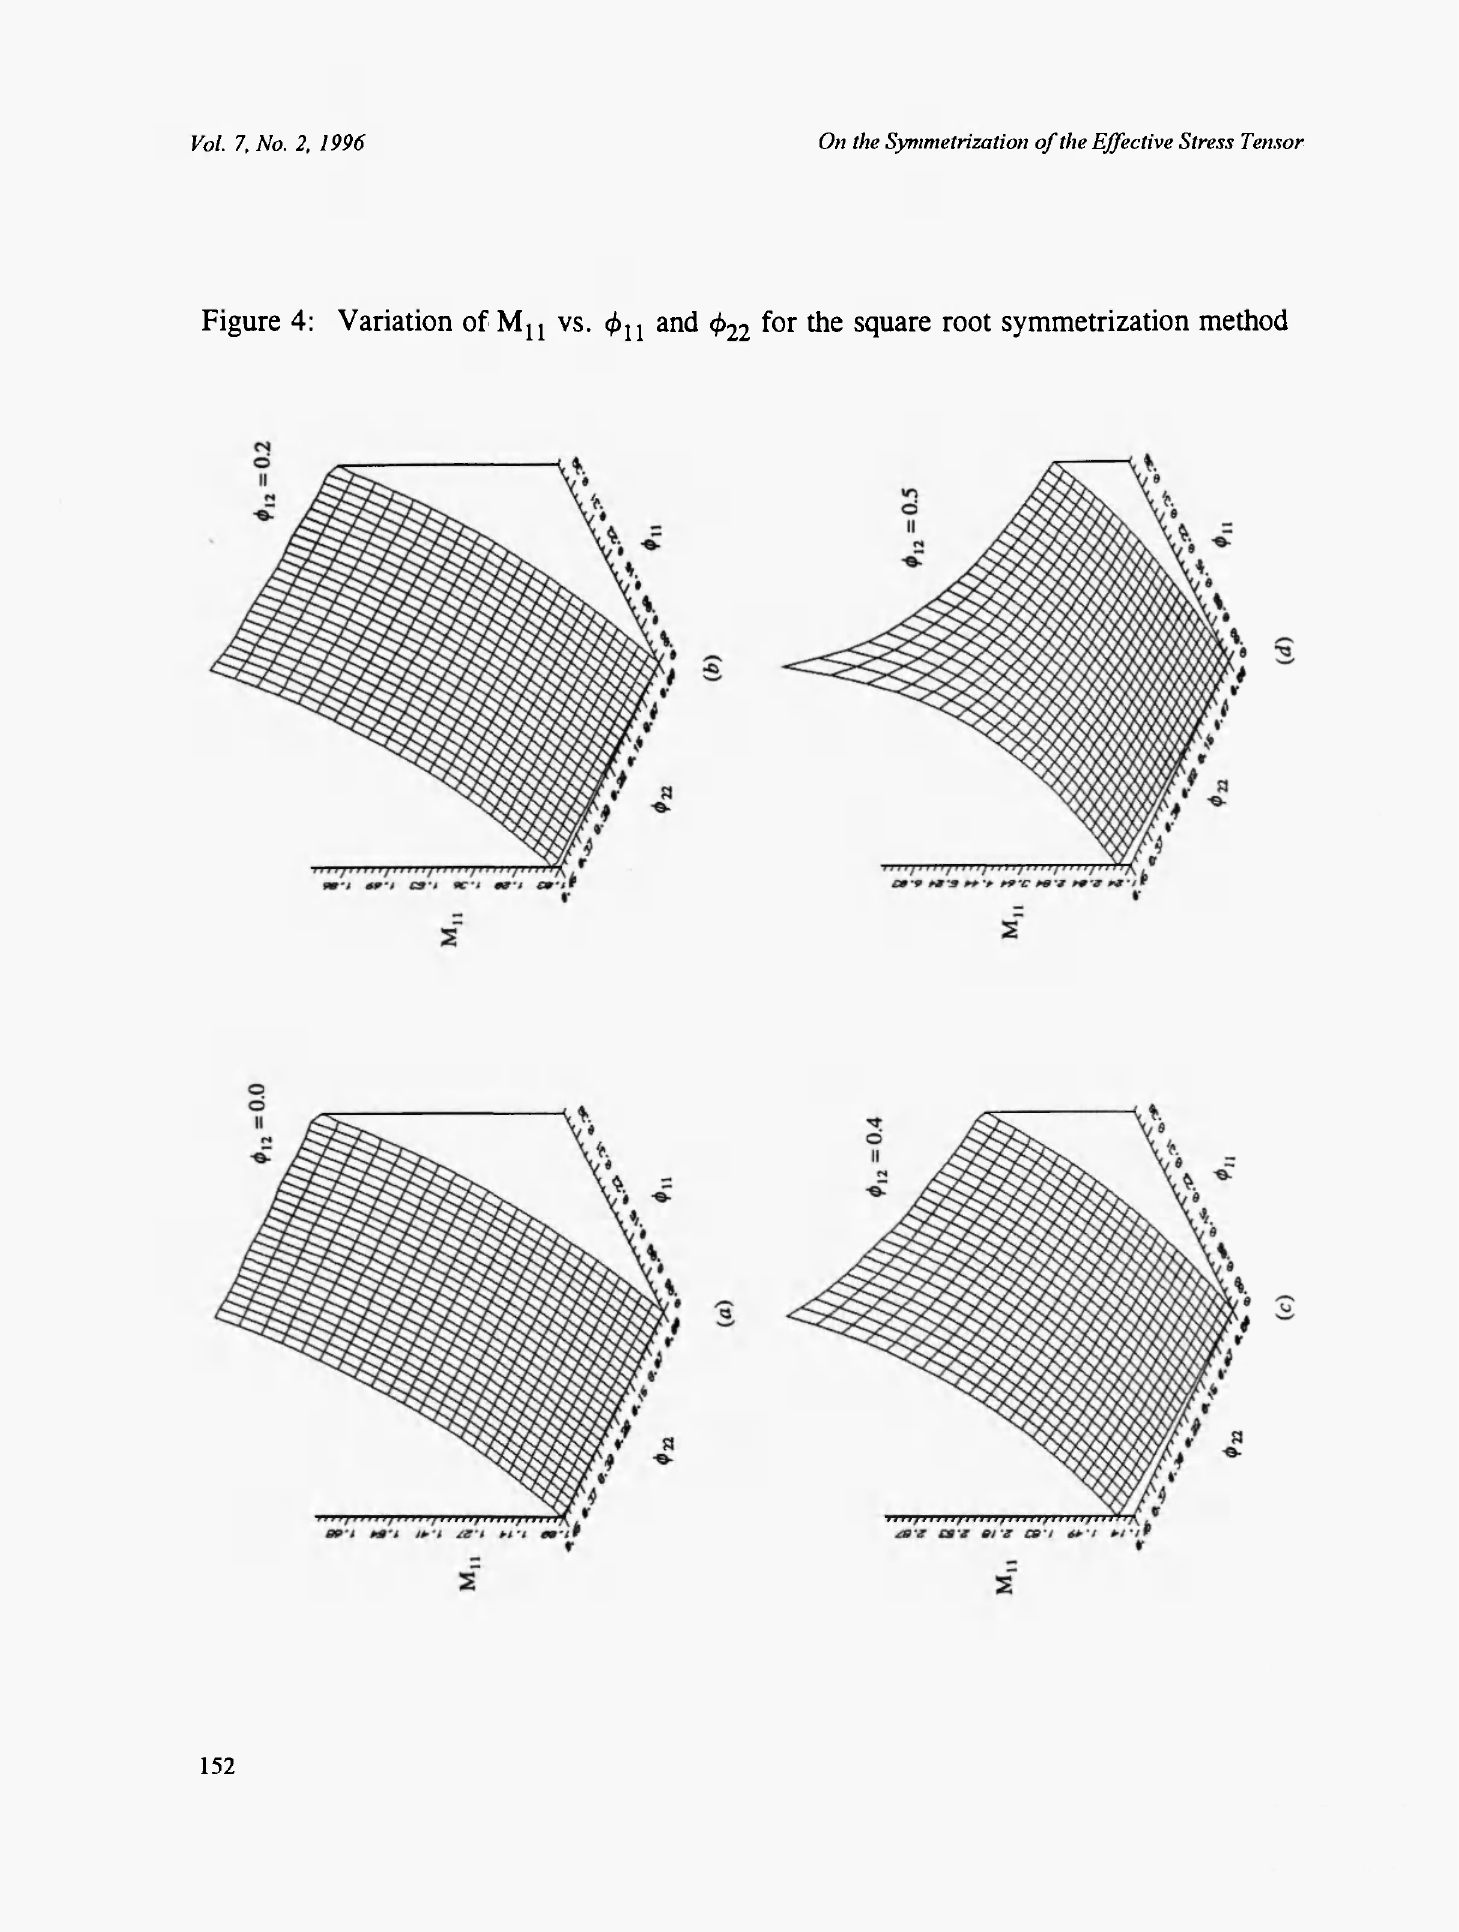
Figure 4: Variation of M